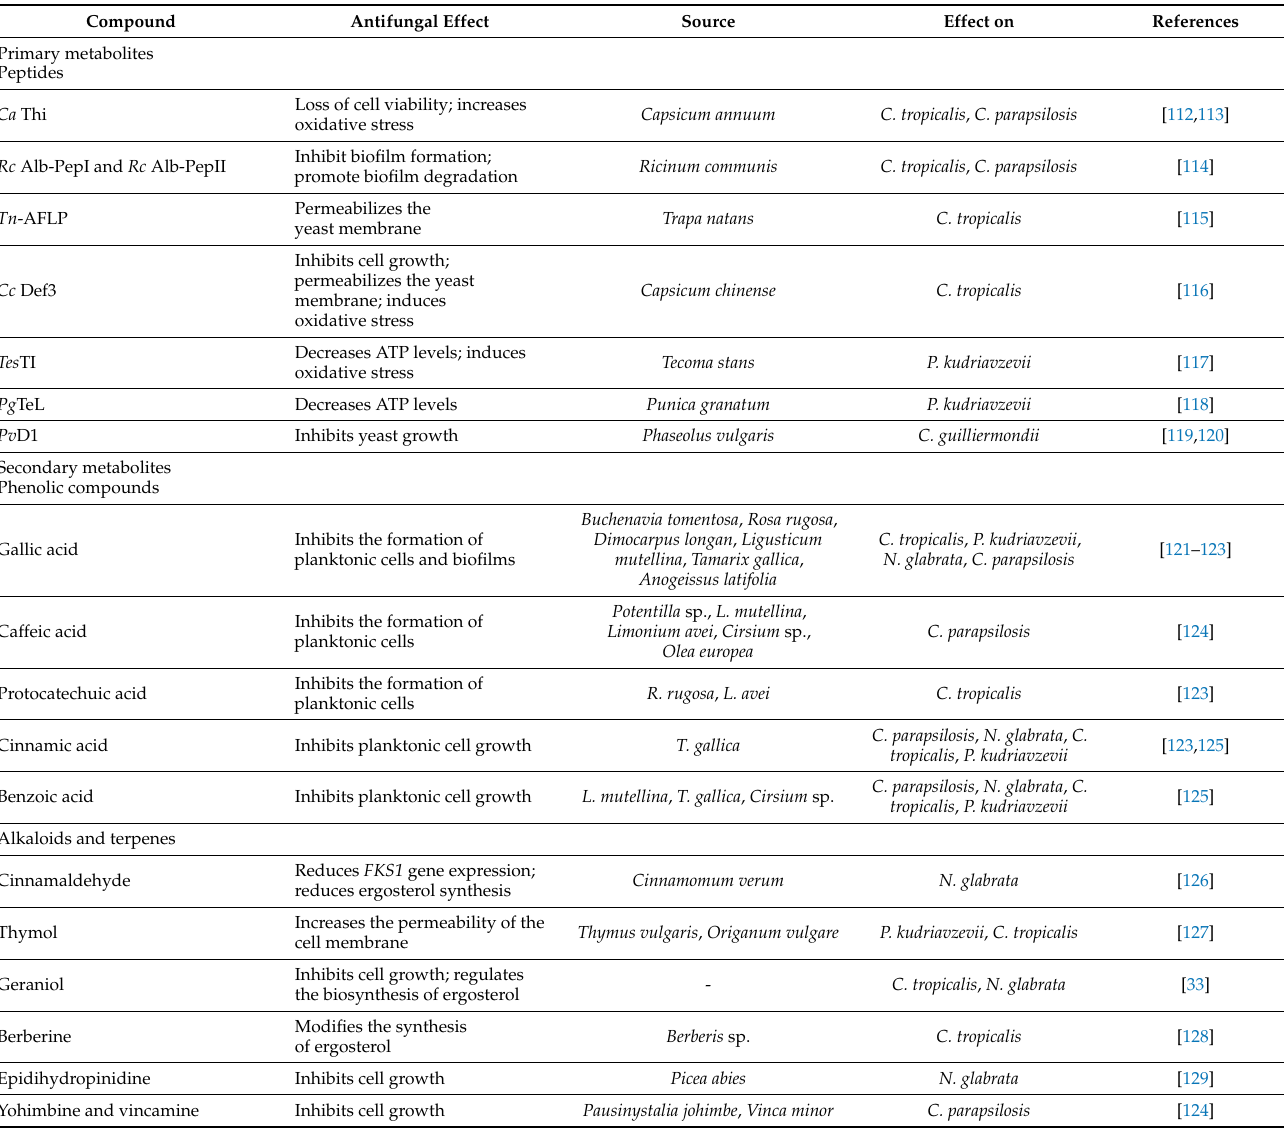
Table 1. Plant-derived compounds with antifungal properties against non- albicans Candida